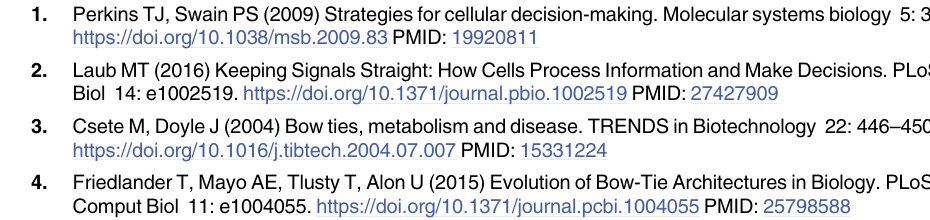
Table 1. Mutations identified in the Wsp system from fleN (cid:3) Δ wspF (see Fig 6G ) . Table 2. Primer sequences used in this